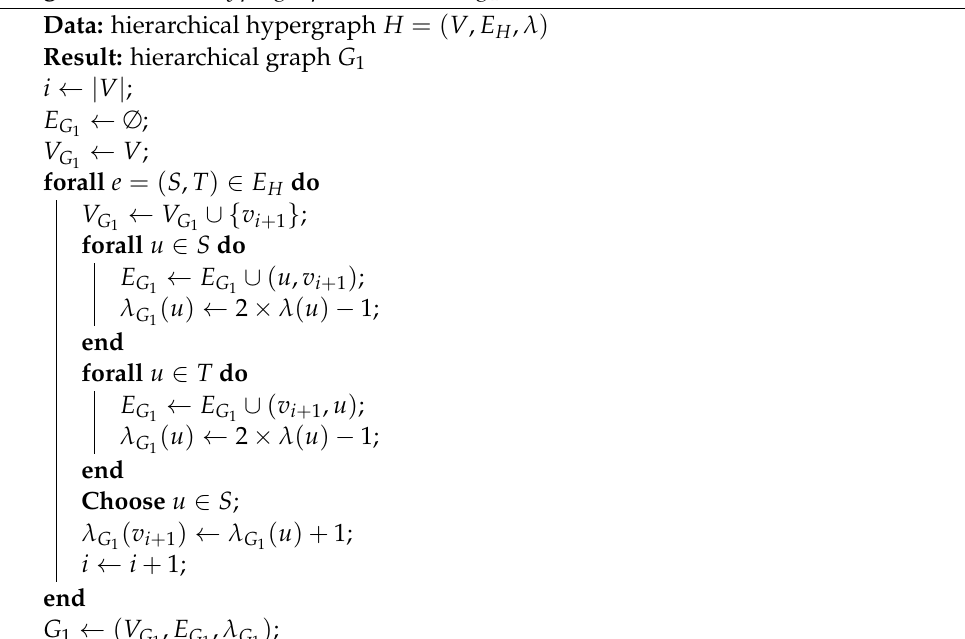
Algorithm 2: The hypergraphRestructuring 1